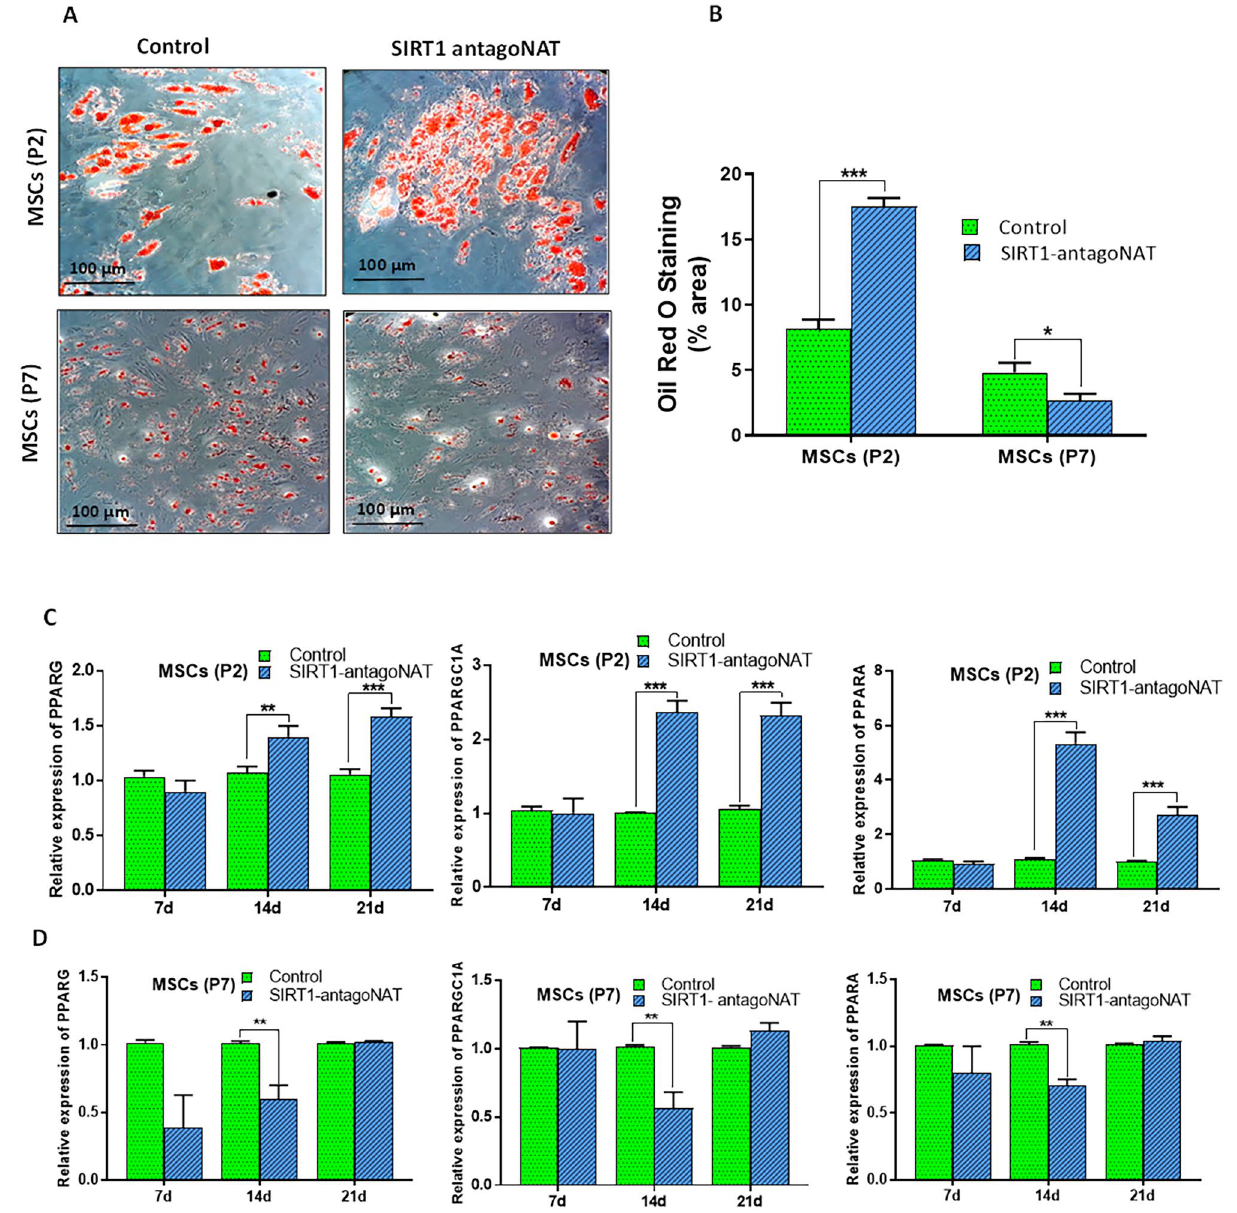
Figure 7. Knockdown of SIRT1-NAT improves the adipogenic differentiation potentials of MSCs. ( A ) Representative photomicrographs which show the Oil Red O staining following the adipogenic induction of P2 and P7 MSCs transfected with SIRT1-antagoNAT and their controls. ( B ) Bar graphs quantifying the results of Oil Red O staining represented in ( A ). Compared with controls, the percentage of area stained by Oil Red was higher in SIRT1-antagoNAT treated P2 MSCs directed toward osteogenic fate. A contrasting result was found in P7. ( C , D ) Bar graphs showing the relative expressions of PPARγ, PPARα, and PGC1α (adipogenic marker genes) in P2 ( C ) and P7 ( D ) MSCs treated with SIRT1-antagoNAT and their controls during the 3 weeks period of osteogenic induction, as determined by RT-qPCR. Each time point was used as its own reference. The results of P7 were not consistent with that of P2. Data are expressed as mean ± SD (n = 3). Data in B are obtained from 6 microscopic fields (2 independent experiments). * p < 0.05, ** p < 0.01, *** p <